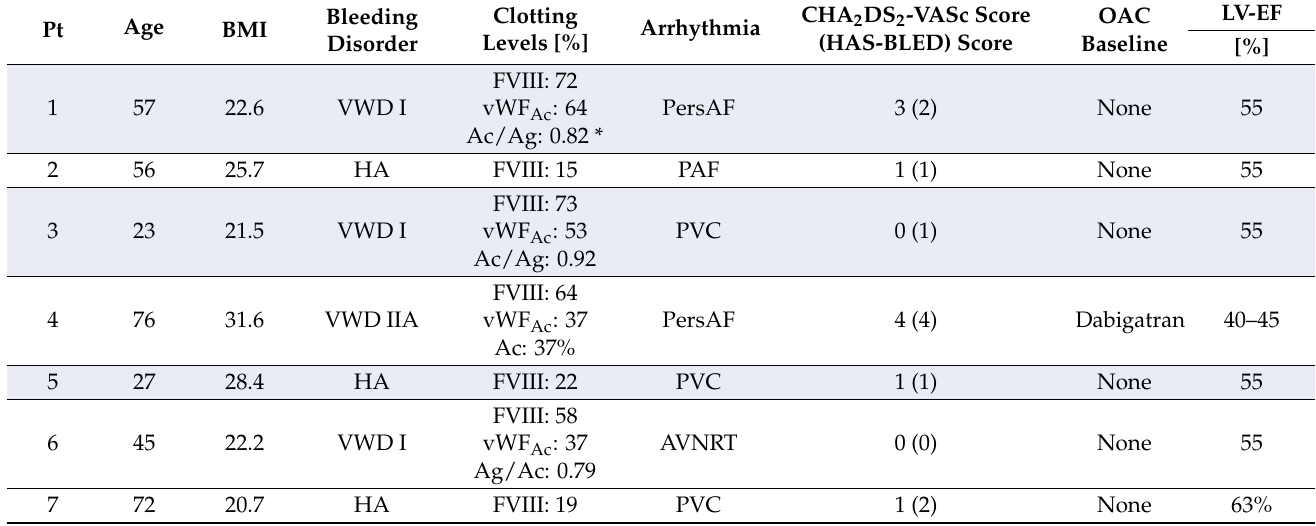
Table 1. Baseline